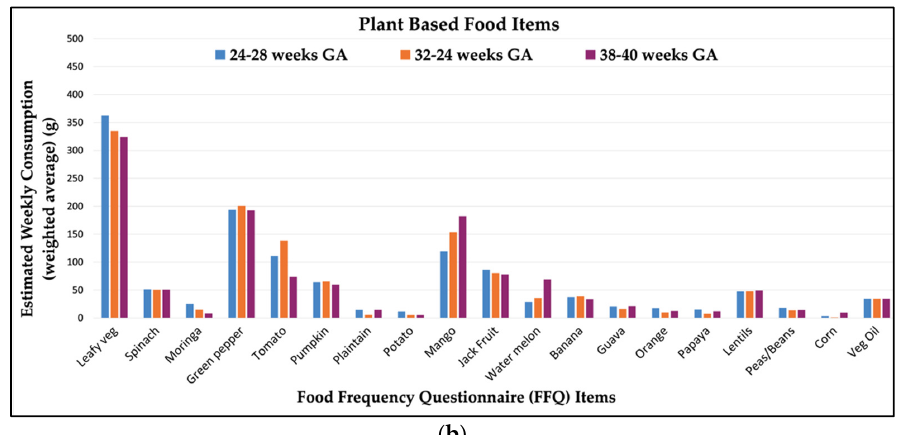
Figure 1. Estimated average weekly consumption (grams) of food items through the course of gestation among ( n = 251) pregnant women in Sylhet, Bangladesh: ( a ) animal source and ( b ) plant-based food items.